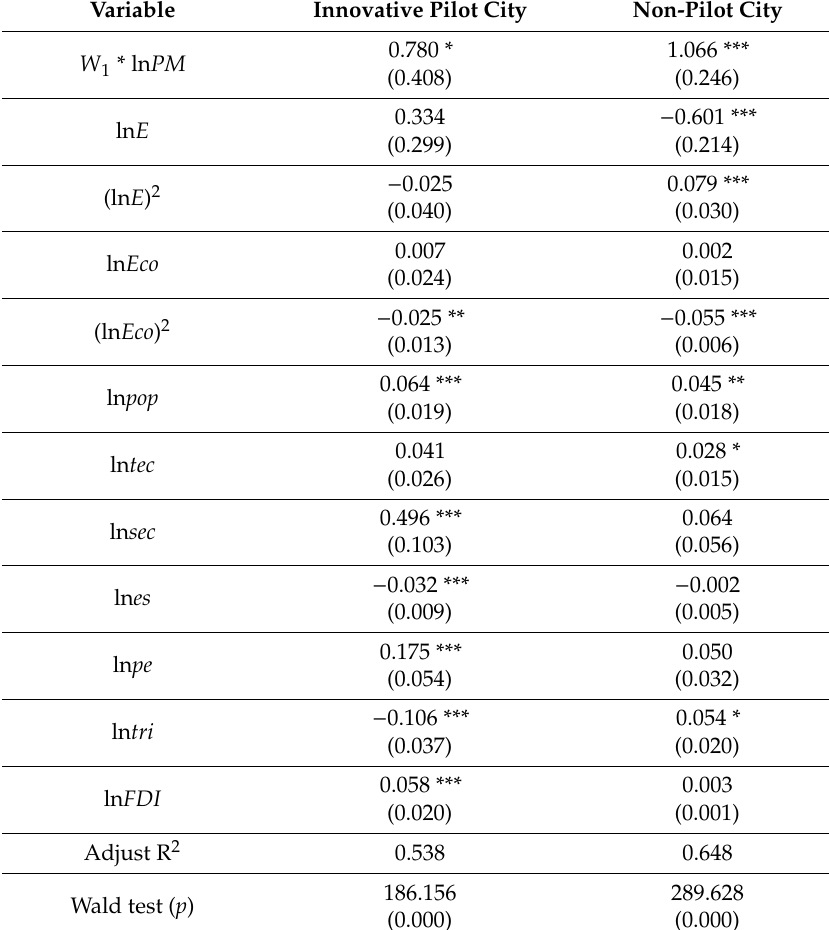
Table 5. Sample regression by region.